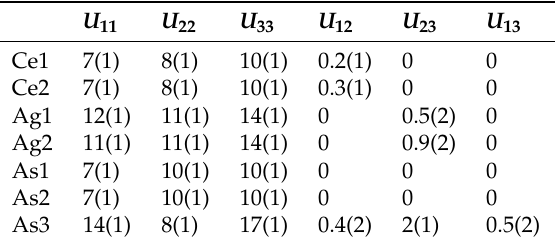
(cid:2) (cid:3) h 2 a ∗ 2 U 11 + ... + 2 hka ∗ b ∗ U 12